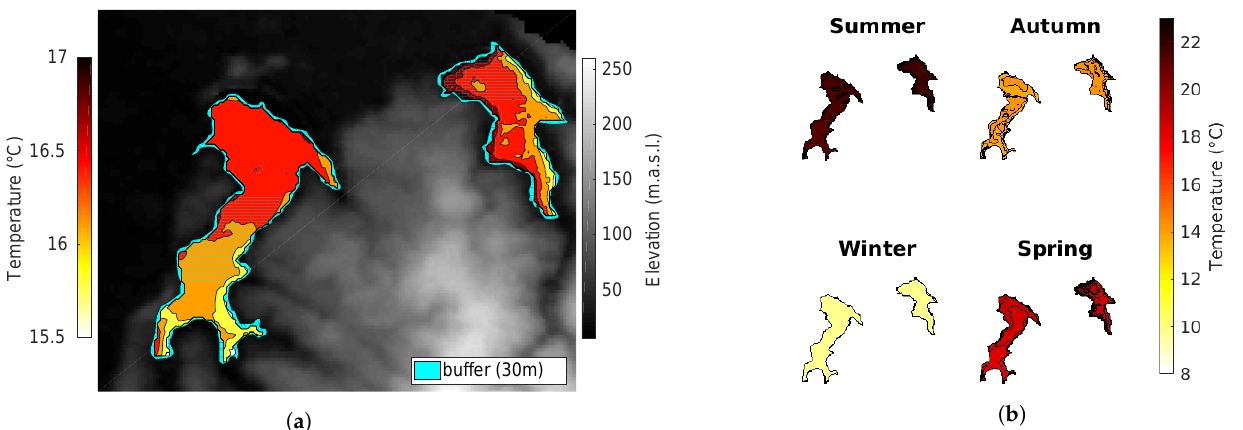
Figure 5. ( a ) Average annual climatology of the studied lakes obtained from the M5 method applying a buffer of 30 m (in cyan). ( b ) Seasonal mean. Lagunas Grande and Chica de San Pedro to the left and right, respectively.